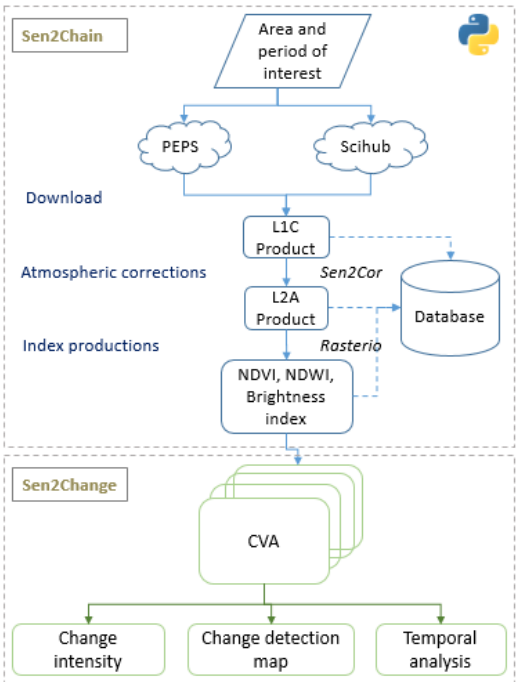
Figure 2. General architecture and data flow between Sen2Chain and